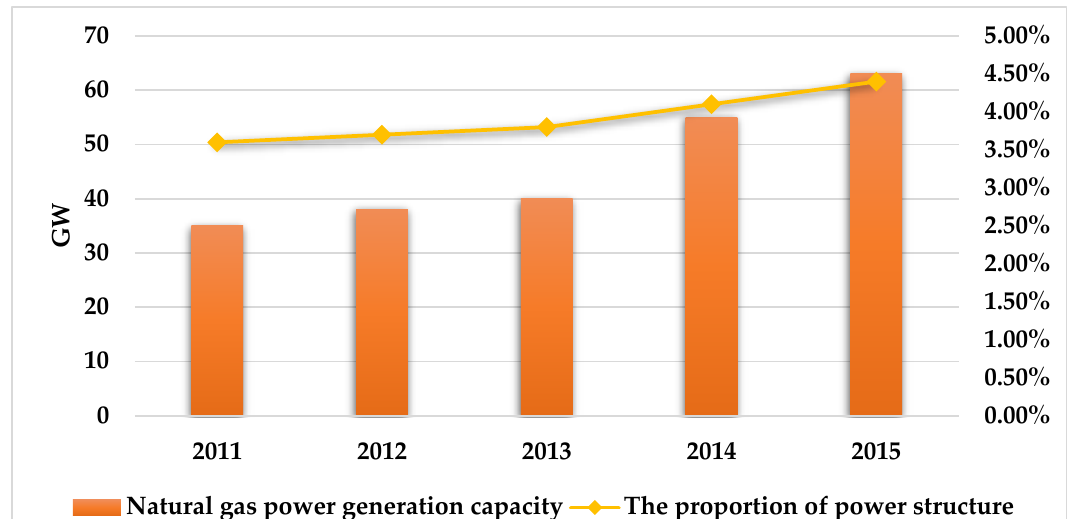
Figure 1 The installed capacity and proportion of NGPG during 2011–2015. Figure 1. The installed capacity and proportion of NGPG during